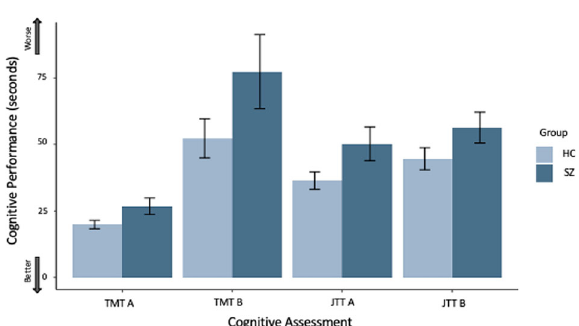
Fig. 3 Differences in cognitive performance between individuals with schizophrenia and healthy controls on in-lab cognitive assessments. JTT Jewels Trail Tests, TMT Trail Making Tests, HC healthy controls, SZ individuals with schizophrenia/schizoaffective disorder. All comparisons survive Bonferroni corrections p < 0.05. Error bars represent 95% con fi dence intervals. Cognitive perfor- mance was measured in seconds where a greater completion time represents a poorer